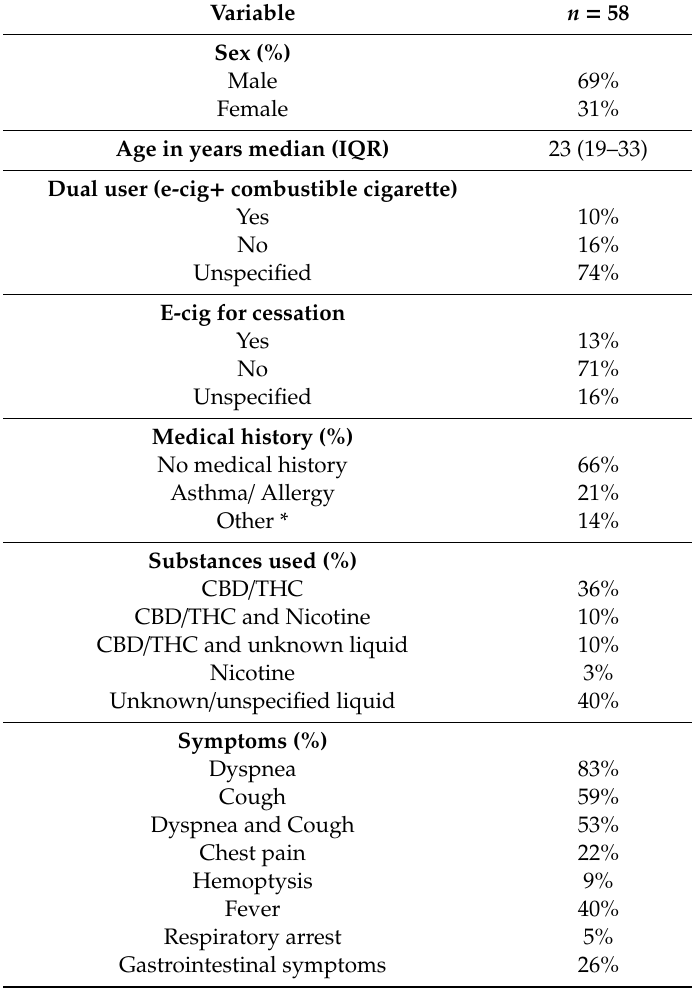
Table 2. Respiratory cases: demographic, clinical, laboratory findings, and